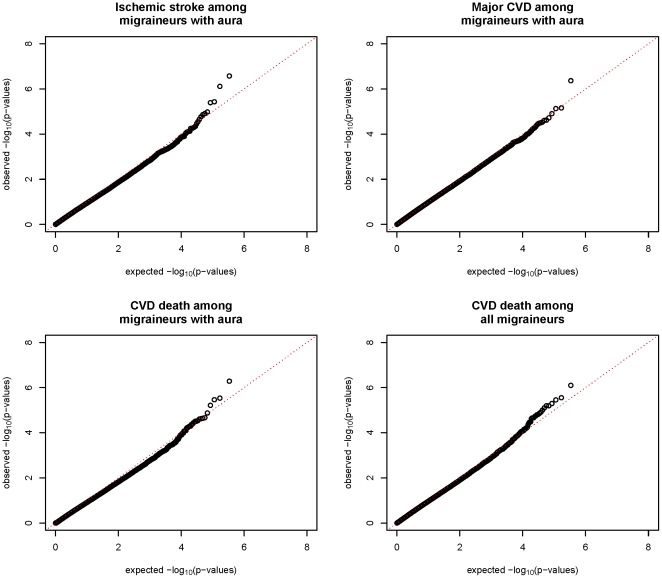
Quantile-quantile plots for the association between SNPs and CVD among women with migraine.